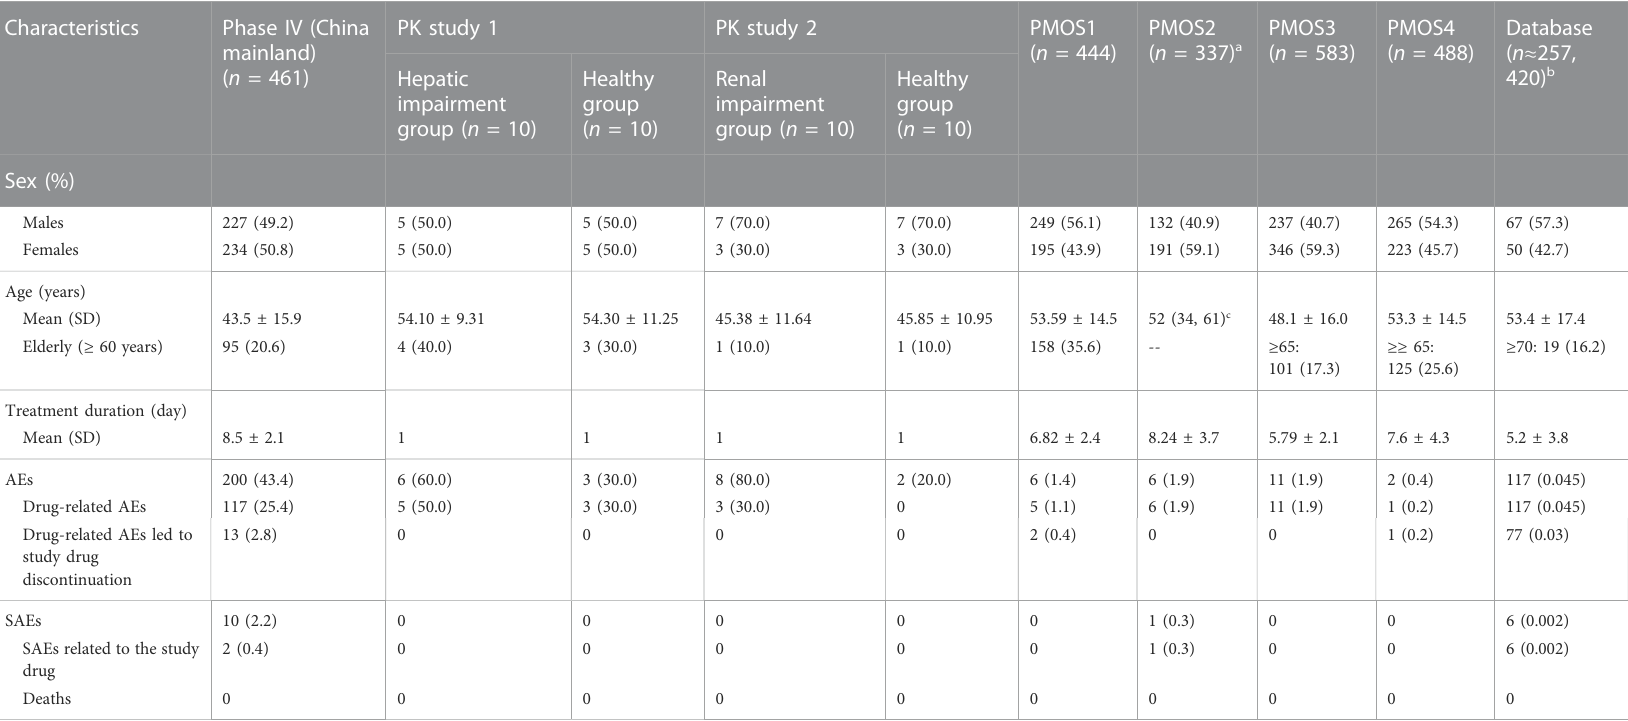
TABLE 4 Summary of nemonoxacin 500 mg in postmarketing